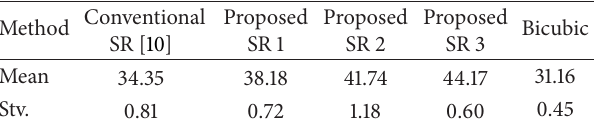
Table 1: Comparison of the averaged PSNR for an aligned face database